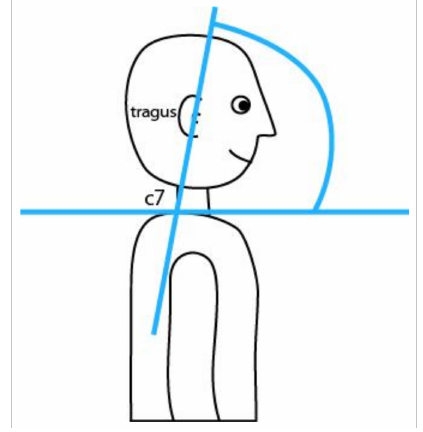
Figure 1. Illustration of craniovertebral